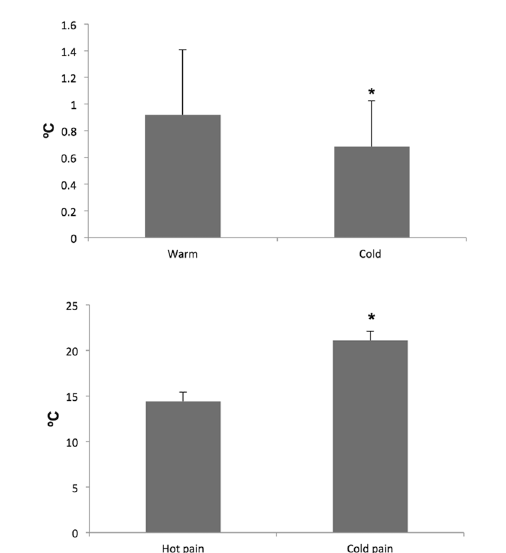
Figure 2. Temperature perception thresholds and pain threshold at baseline condition. Thresholds were expressed as the difference of the obtained value with respect to the starting temperature of 32